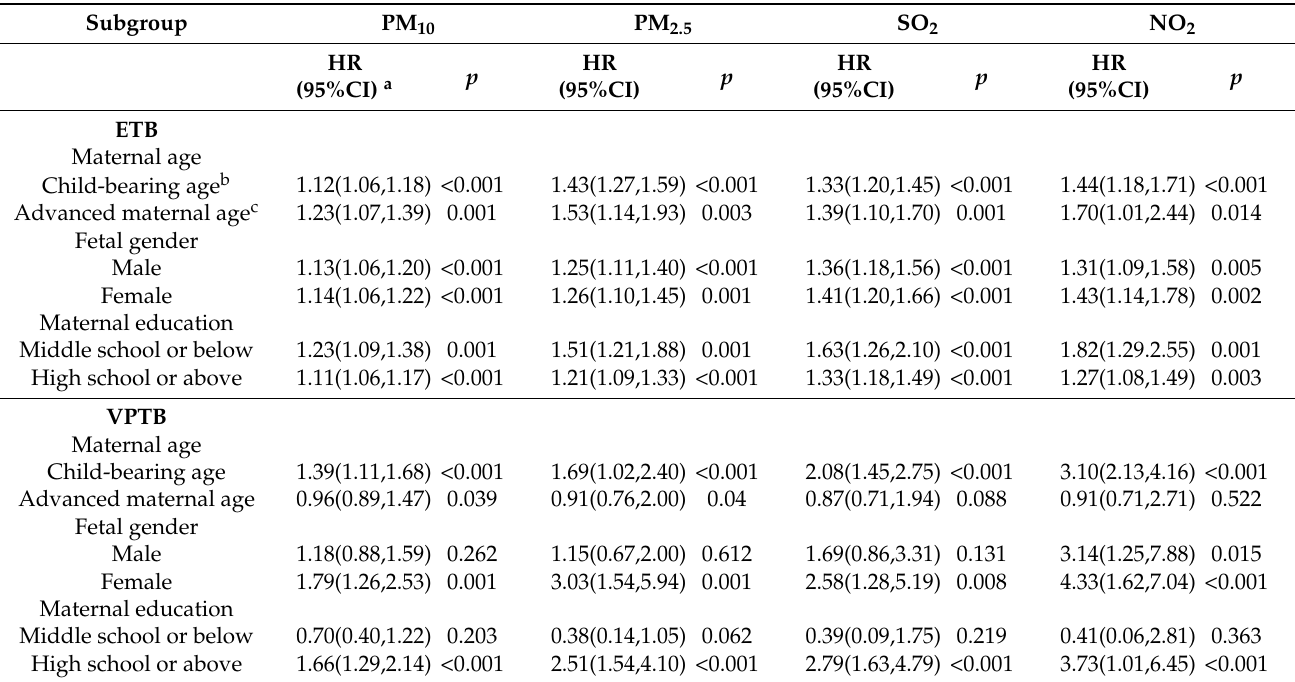
Table 3. HR of ETB and VPTB for a 10- µ g/m 3 increase of each pollution over an entire pregnancy stratified by the maternal age, fetal gender, and maternal